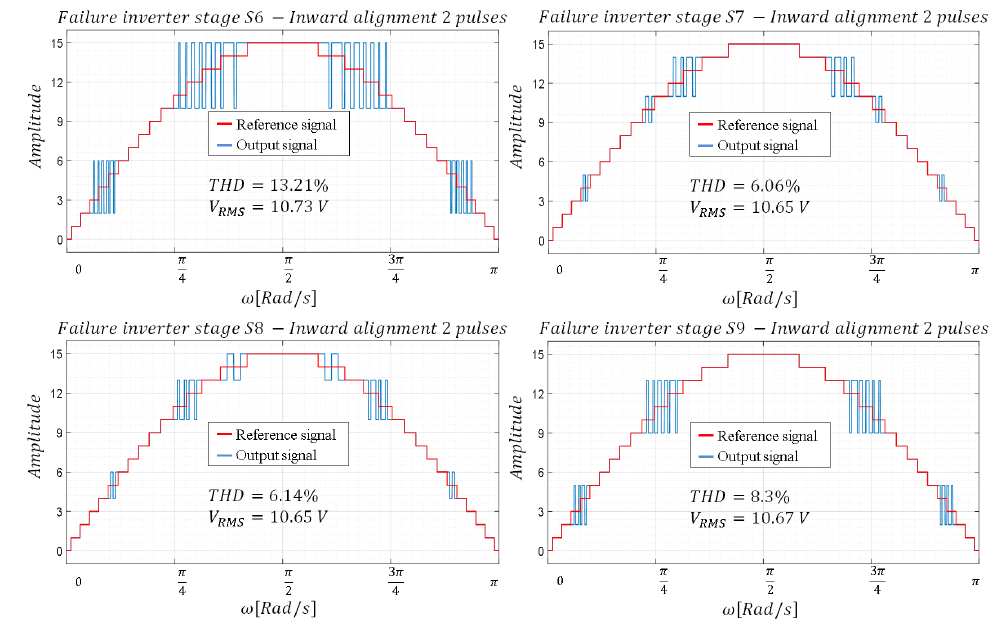
Figure 8. Waveforms—configuration with two pulses and inward